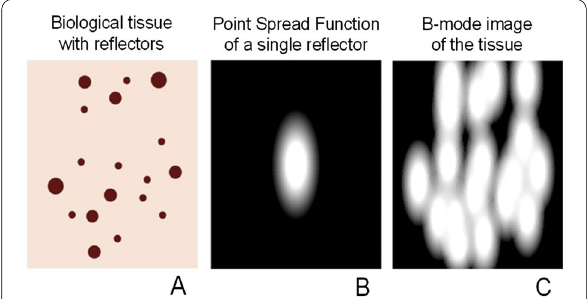
Fig. 4 B-mode images do not provide a resolved signature of the tissue cellular content. a Single cells or structured connected cells forming a living tissue are providing acoustic impedance interfaces reflecting or scattering compressive waves emitted by the ultrasound probe. b These backward waves are detected by the same probe but are filtered by the “point spread function” of the ultrasound system. In other words, the limited resolution of ultrasound coupled with probe characteristics and scanner settings do not allow resolving single cell geometry. The “point spread function” can be interpreted as the image that would be produced by a single reflector much smaller